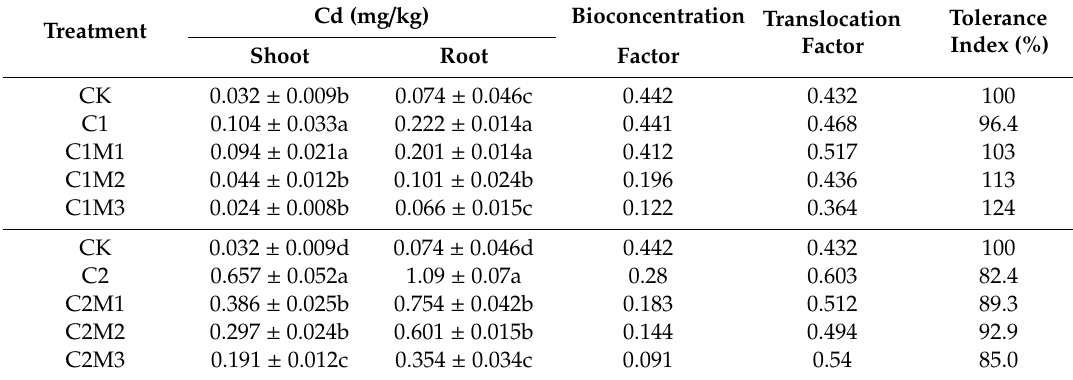
Table 4. The changes of Cd content in rape plants with the co-treatment of Mo and Cd ( n = 4). Cd (mg / Treatment